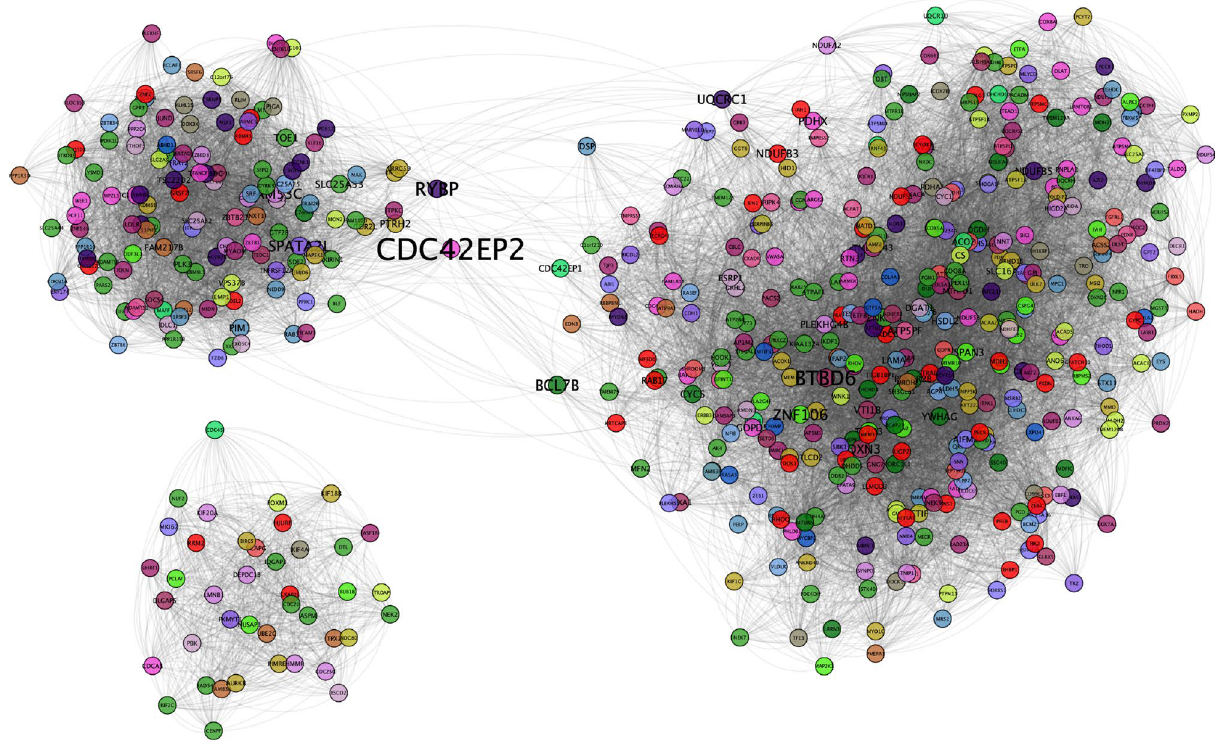
Figure 3. 30-core healthy GCN. In this representation, genes are colored according to the chromosome they belong to.